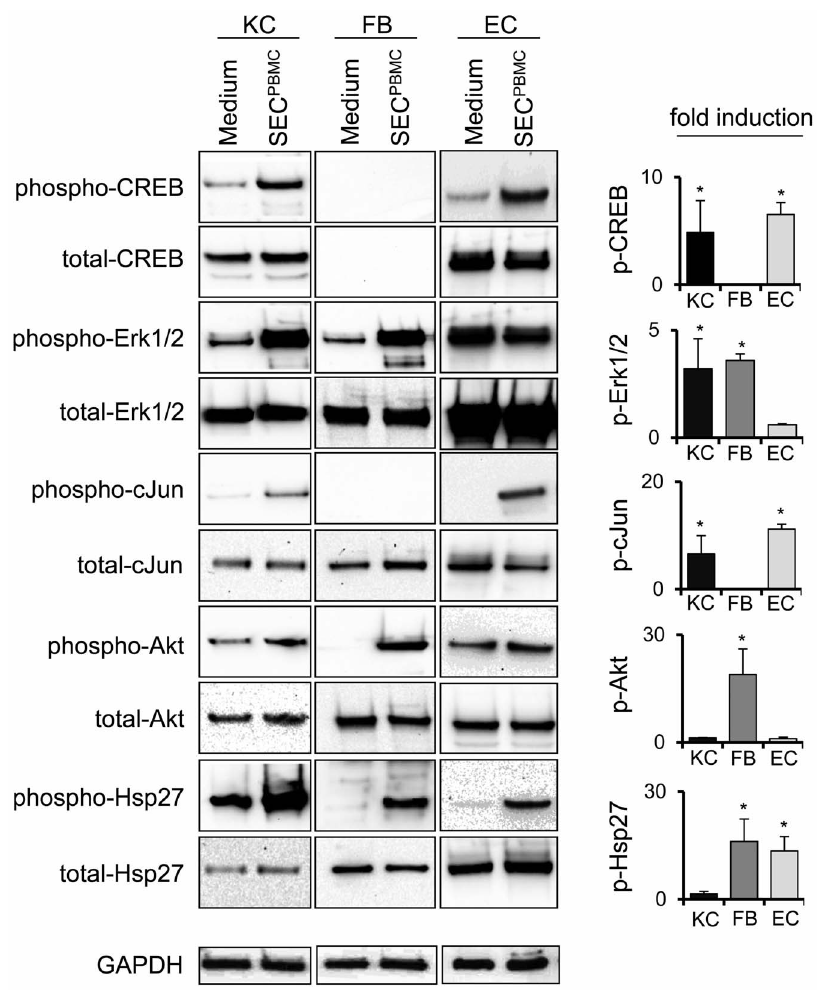
Figure 4. SEC PBMC leads to activation of several signaling cascades. KC, FB and EC were treated for 1 h with medium or SEC PBMC . Western blot analyses of several signaling factors are shown. One representative experiment of three is shown. The graphs in the right panel represent the mean band intensity of all three experiments. The increase in expression of the phosphorylated proteins was calculated in relation to the respective non-phosphorylated proteins (*: p , 0.01).